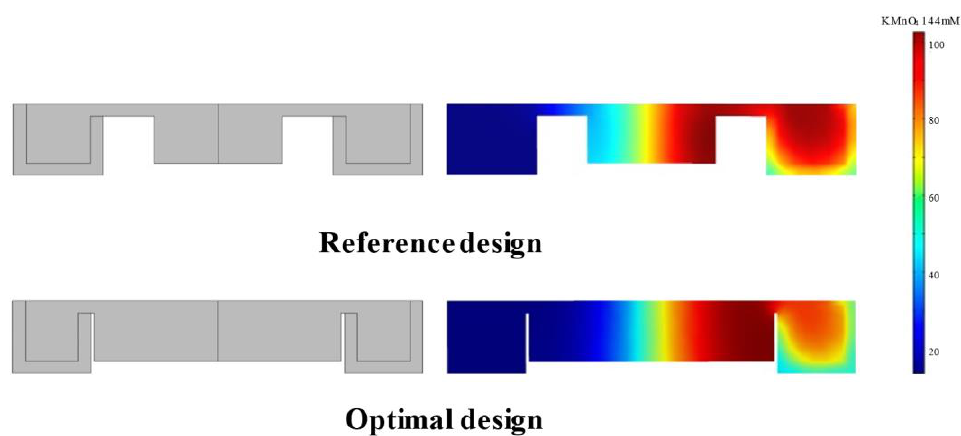
Figure 7. Comparison of oxidant (KMnO 4 ) concentration contours on x-z plane 5 mm downstream of the channel inlet between reference design [30] and optimal design.